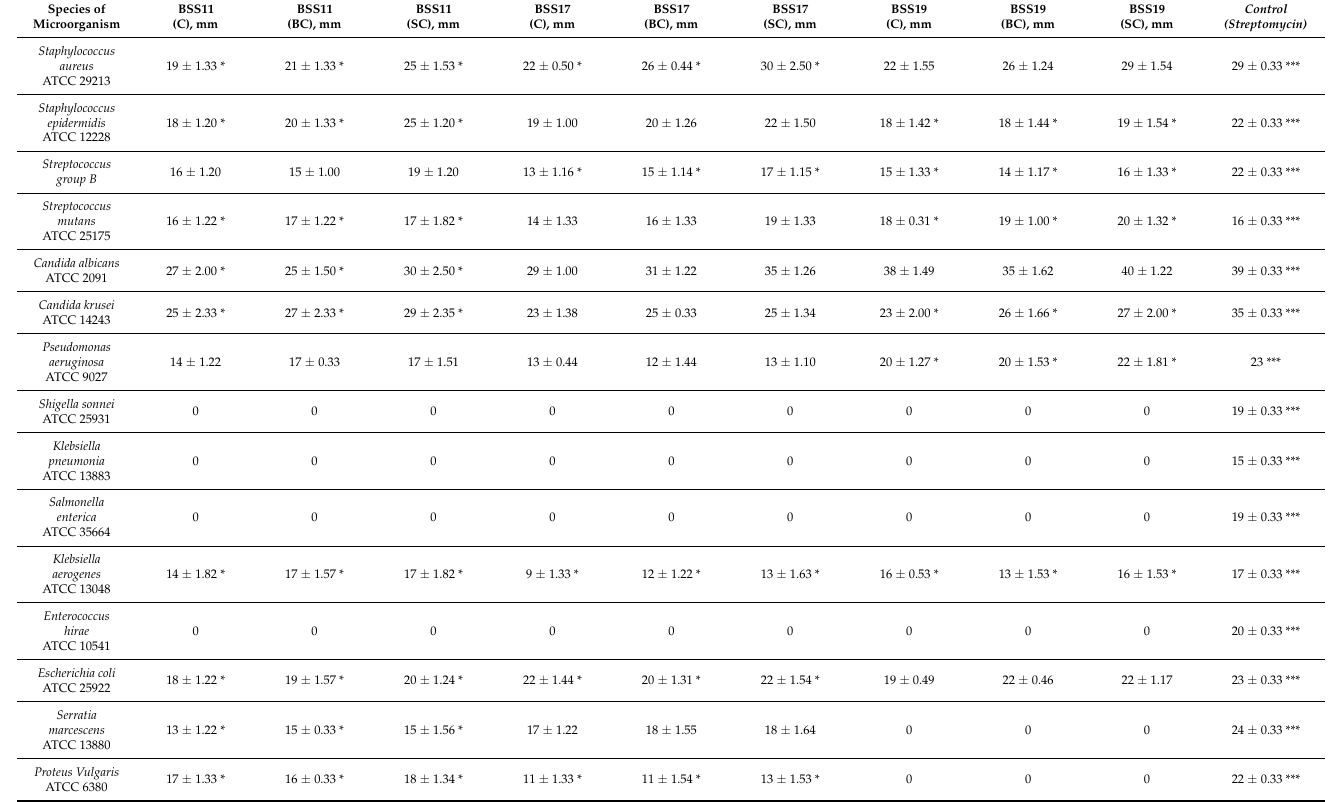
Table 2. Antibacterial activity of the bacterial culture extracts against pathogenic